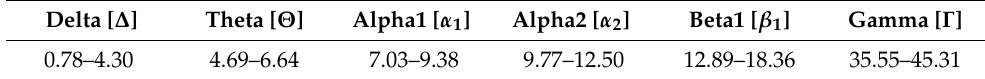
Table 1. Frequency ranges for computing spectral power.